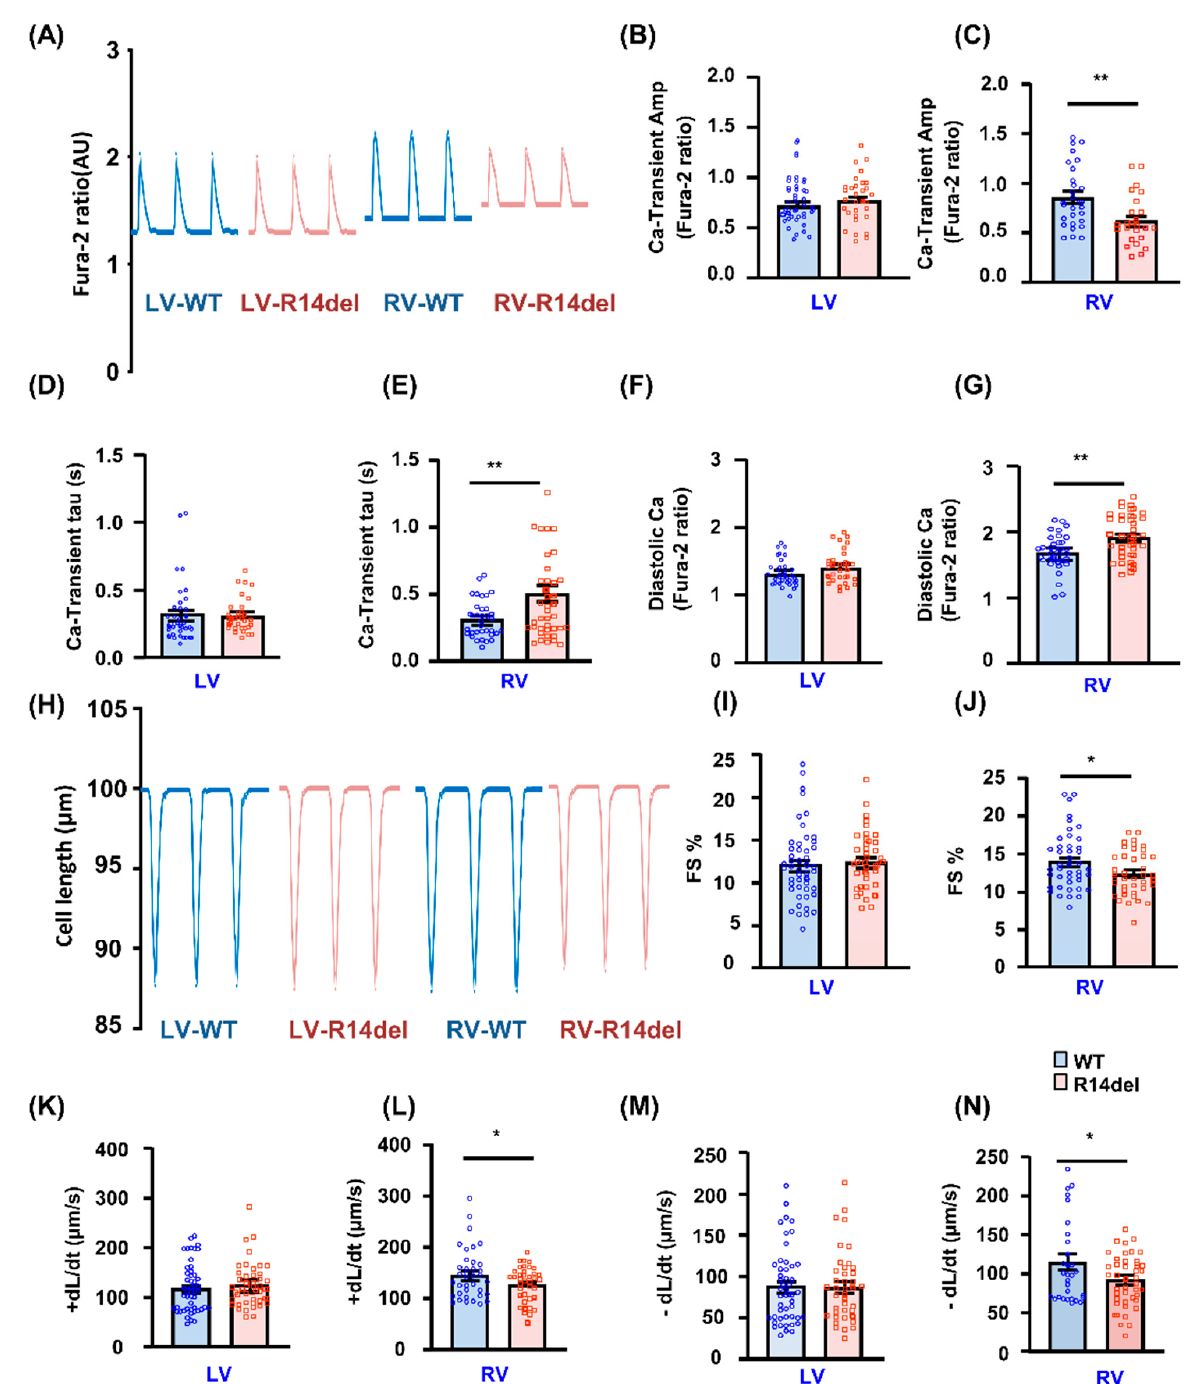
Figure 4. Ca-kinetic and contractile parameters in isolated cardiomyocytes. ( A ) Representative traces of Ca-transients; ( B , C ) Ca transient amplitude, indicated by fura-2 ratio (340:380 nm). ( D , E ) The relaxation time constant (Tau) of the Ca-transient decay. ( F , G ) Intracellular diastolic Ca levels in LV and RV myocytes. N = 36 LV and 35 RV cells for WT (N = 4 hearts); n = 34 LV and 41 RV cells for R14del-PLN (N = 4 hearts). ( H ) Representative cell shortening traces. ( I – N ) Contractile parameters: Fractional shortening (FS%) and maximum rates of contraction (+dL/dt) and re-lengthening ( − dL/dt) in LV and RV myocytes at 0.5 Hz. N = 43 LV and 50 RV cells for WT (N = 4 hearts); n = 40 LV and 43 RV cells for R14del-PLN (N = 4 hearts. Data are expressed as mean ± SEM for the number of cells, and statistical analyses were performed by Student’s unpaired t-test. * p ≤ 0.05 vs. WT-PLN; ** p ≤ 0.001 vs. WT-PLN.